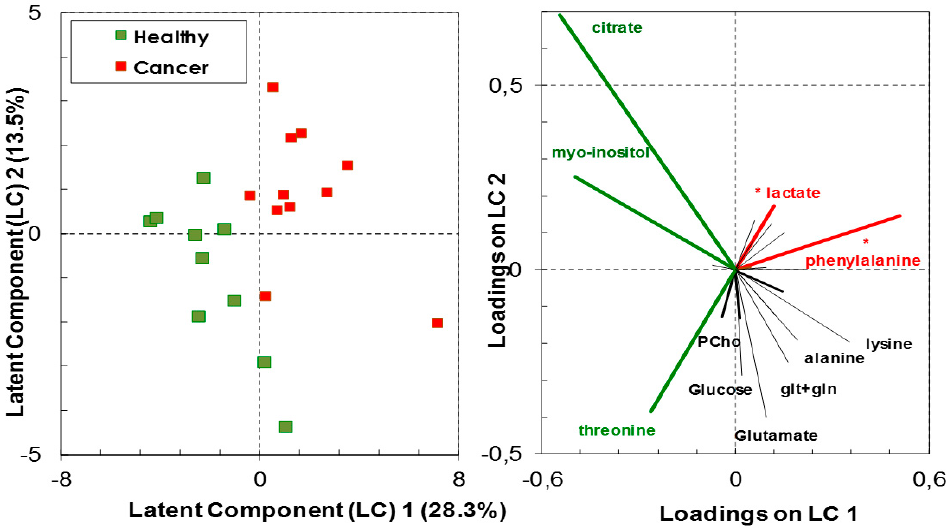
Figure 2. Discrimination between healthy and cancer thyroid tissue based on metabolites analyzed by high-resolution 1 H-NMR (scores—left panel). The most important metabolites (VIP > 1.3) in the partial least squares discriminant analysis (PLS-DA) models are indicated in green or in red (loadings—right panel). Green indicates higher proportion of metabolites in healthy tissue relative to cancer tissue, while red indicates the reverse; (*) indicates metabolites contributing with more than 80% of their variance to the latent components.